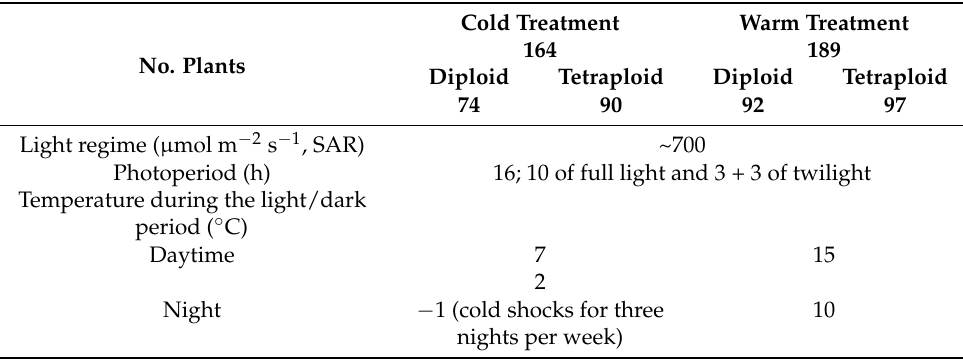
− 1 (cold shocks for three nights per week)